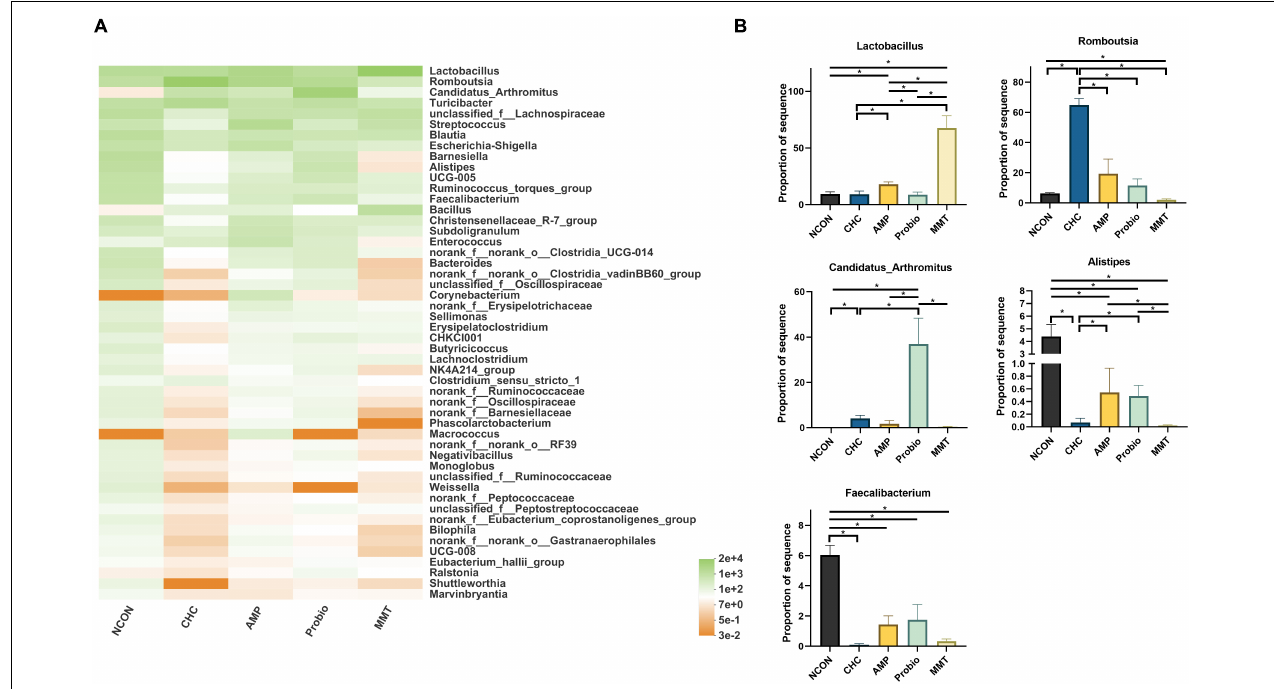
FIGURE 5 | Effects of dietary treatment on intestinal microbiota composition in the ileum at the genus level. (A) Ileal bacterial community heatmap at the genus level in broilers. (B) Significant alterations of the abundance of bacterial genera found in the ileum of broilers. NCON is a corn-soybean meal basal diets group. AMP is 200 mg/kg antibacterial peptide supplemented group. Probio is 200 mg/kg calsporin supplemented group. MMT is 500 mg/kg montmorillonite supplemented group. CHC is 500 mg/kg activated charcoal-herb extractum complex supplemented group. P values calculated using the ANCOM test and were adjusted by false discovery rate (FDR) correction according to the Benjamini-Hochberg procedure, and the level of significance was set at FDR < 0.10; * presented FDR < 0.10. Lactobacillus , FDR = 0.060; Romboutsia , FDR = 0.061; Candidatus_Arthromitus , FDR = 0.077; Alistipes , FDR = 0.094; Faecalibacterium , FDR =